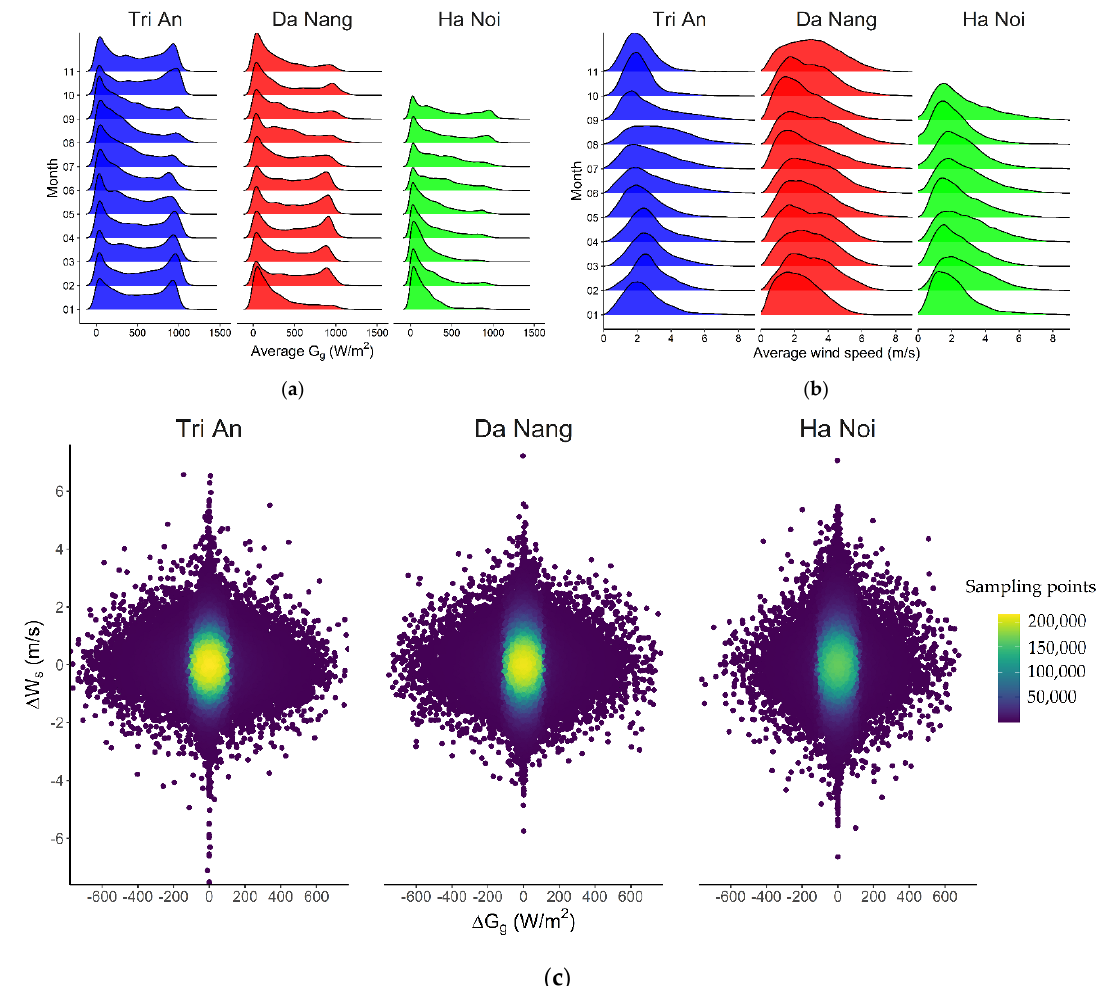
Figure 4. The distribution of POA irradiation and wind in three locations in Vietnam (1-min time step): ( a ) average monthly distribution of POA irradiation level; ( b ) average monthly distribution of wind speed; and ( c ) the variation of POA irradiance and wind speed between two consecutive sampling points.